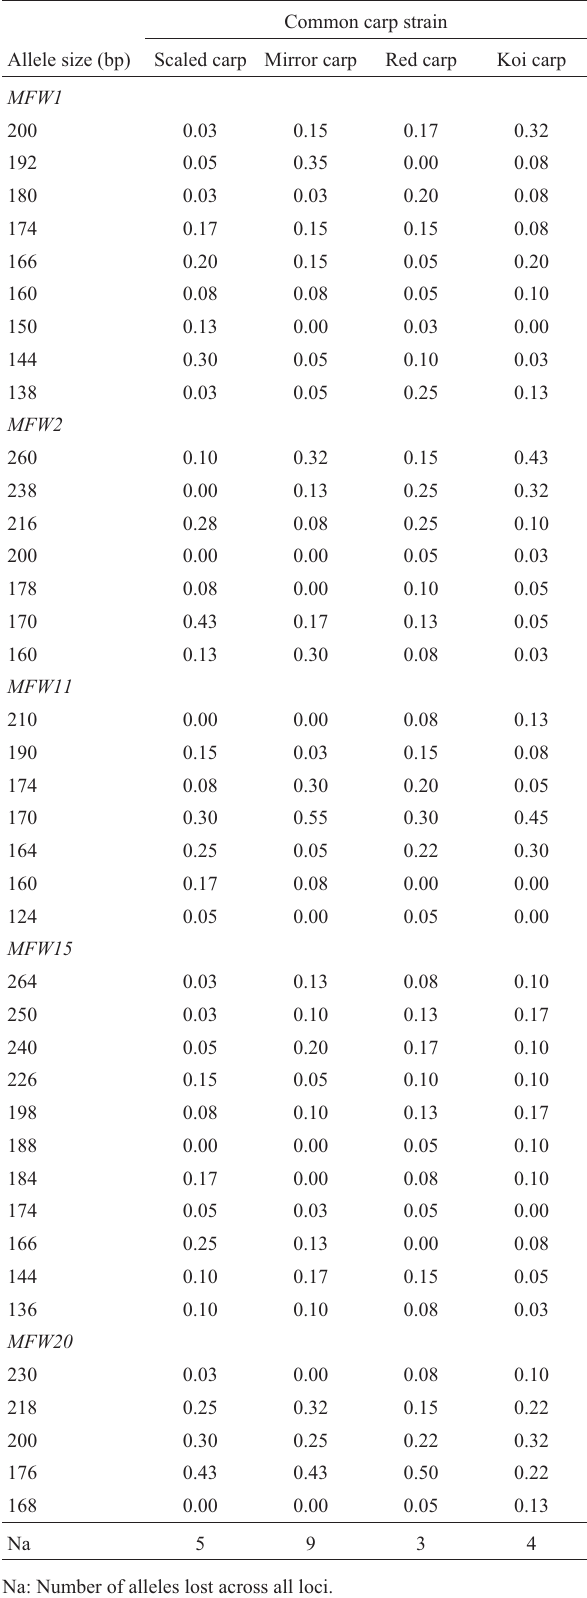
Table 2 - Frequency of alleles at five microsatellite loci in four common carp